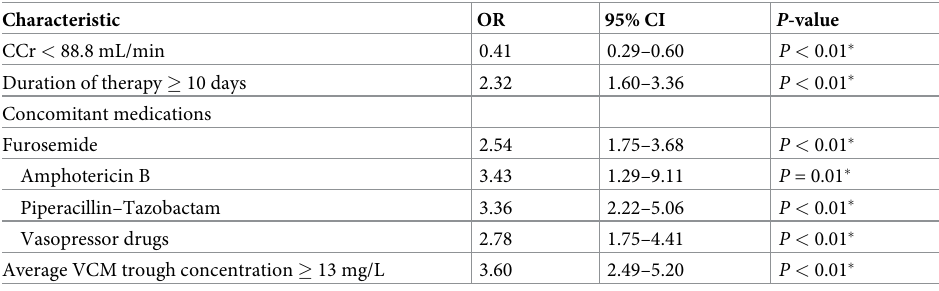
Table 3. Multivariate analysis of risk factors for